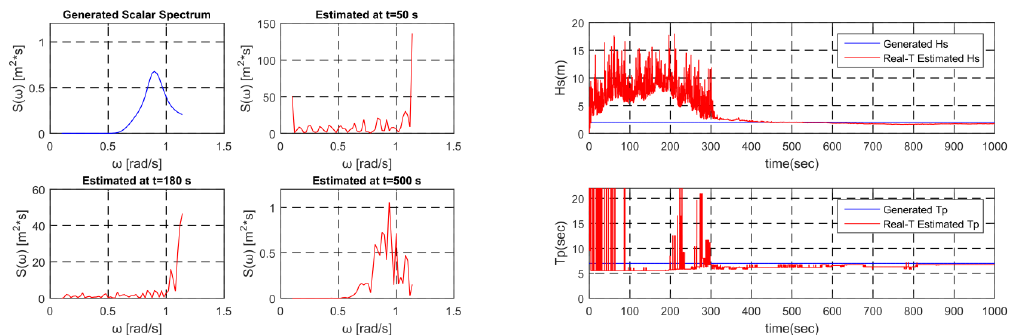
Figure 7. Generated and estimated spectrum / Evolution of parameters (Hs = 2 m, Tp = 7 s, Frequence: 0.1~1.15 rad / s).